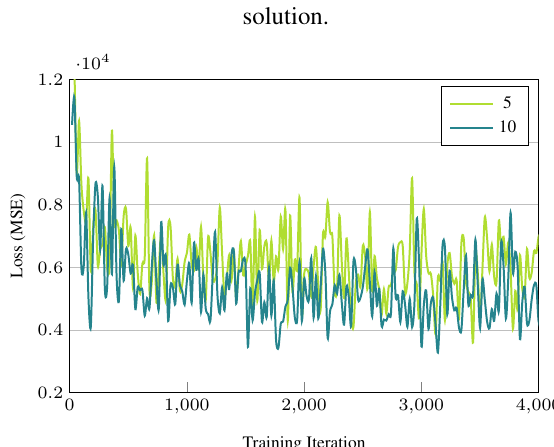
Figure 7. Convergence of the training loss for datasets of different sizes, i.e. , number of used Sentinel-2